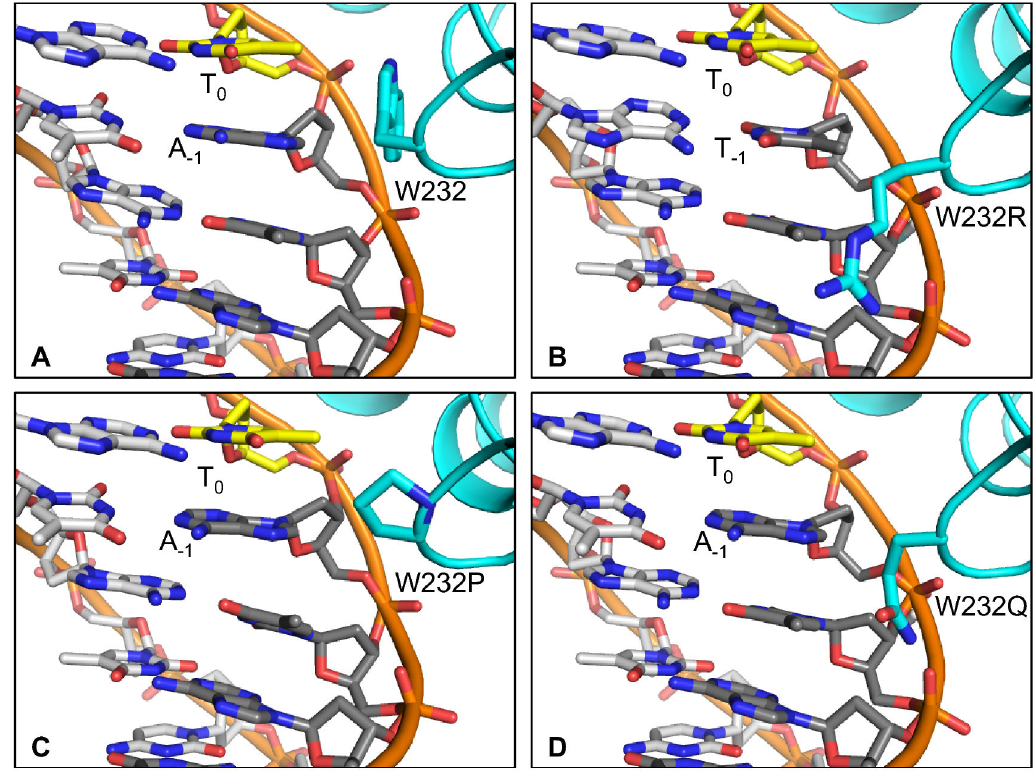
Figure 6. Structural models for representative W232 substitutions. Models were built for all 20 possible amino acids at position 232 with DNA target sites for all 16 nucleotide combinations at positions 0 and -1. Panels A, B, C, and D depict the models for W232, W232R, W232P, and W232Q, respectively. The amino acid at position 232 is labeled using the single letter Code. T the nucleotide at position -1 are also labeled. Models shown are of the DNA target with the highest predicted binding affinity for the corresponding W232 substitution, from the flexible backbone simulations. For these substitutions, differences between the fixed and flexible backbone models are